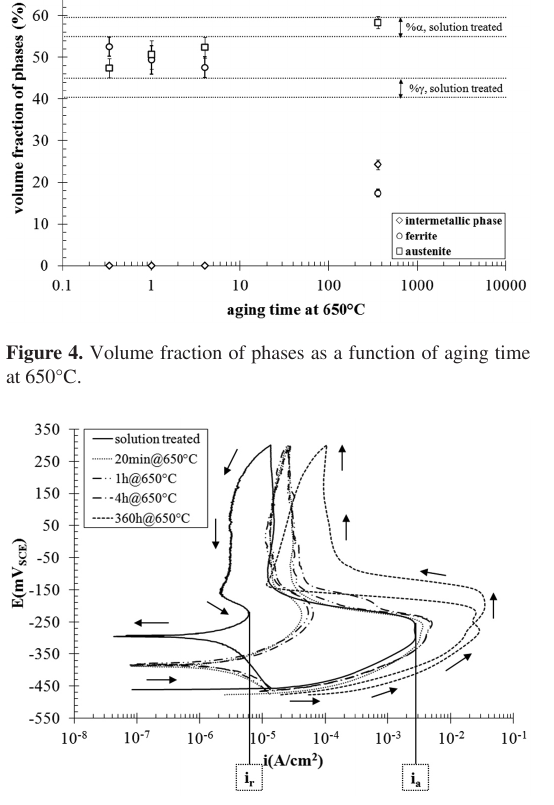
Figure 5. Typical DL-EPR curves in a 1 M H SO + 0.25 M 2 4 NaCl + 0.01 M KSCN solution, for the solution treated sample and for samples aged at 650°C. The maximum anodic current density during the reactivation (i ) and the maximum anodic current density r during the activation (i ) are indicated for the solution treated a sample. Arrows indicate the scanning